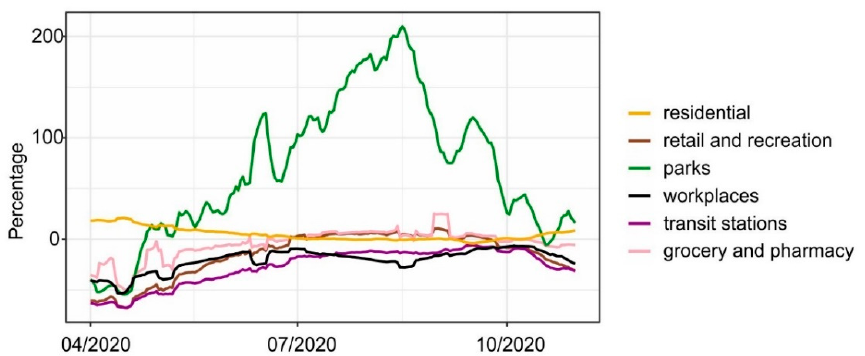
Figure 4. COVID-19 Community Mobile. The raw data were smoothed to the 7-day moving average. The figure presents how the mobility of people has changed compared to the reference period